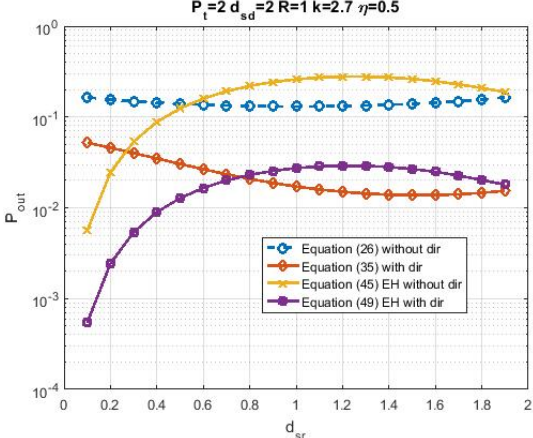
Figure 6. The outage probability with respect to S-R (or S-EHR) distance 𝑑 (cid:3046)(cid:3045) under optimal 𝜌 .